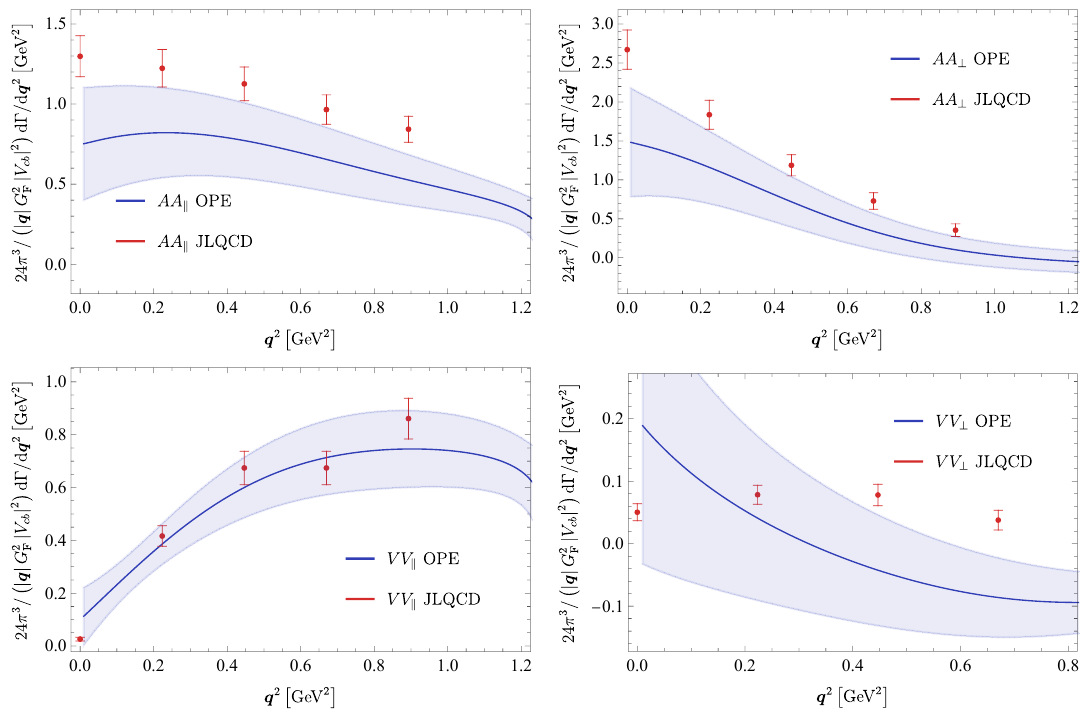
Figure 26 . Differential q 2 spectrum computed with a sigmoid approximation to the kernel with σ = 0 . 1 /a . The plots show the comparison between OPE and JLQCD